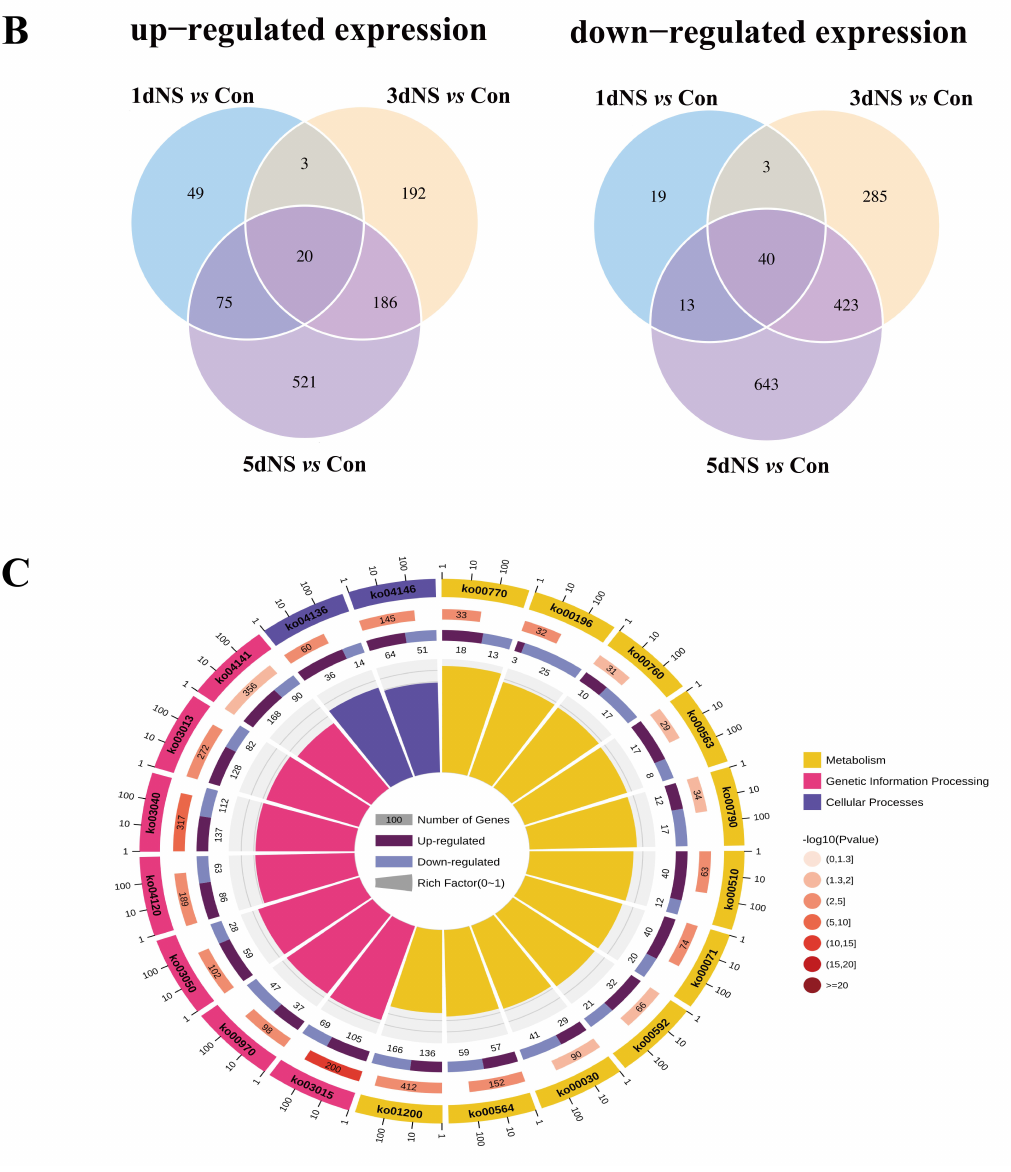
Figure 2. Transcriptome analysis of maize seedling leaves under phospholipase C inhibition. ( A ), vol- cano plot of differentially expressed genes (DEGs); ( B ), Venn diagram of DEGs; ( C ), 5dNS vs. Con Roundup of the top 20 significantly enriched differential pathways (yellow: metabolism; pink: genetic information processing; purple: cellular